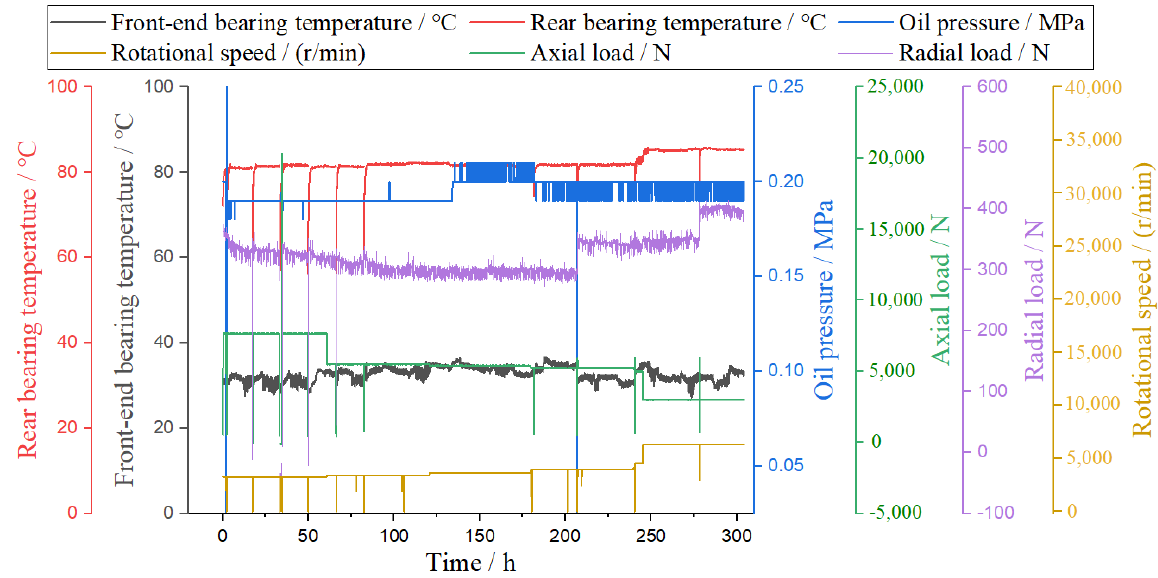
Figure 4. High-temperature durability testing of high-performance bearings.